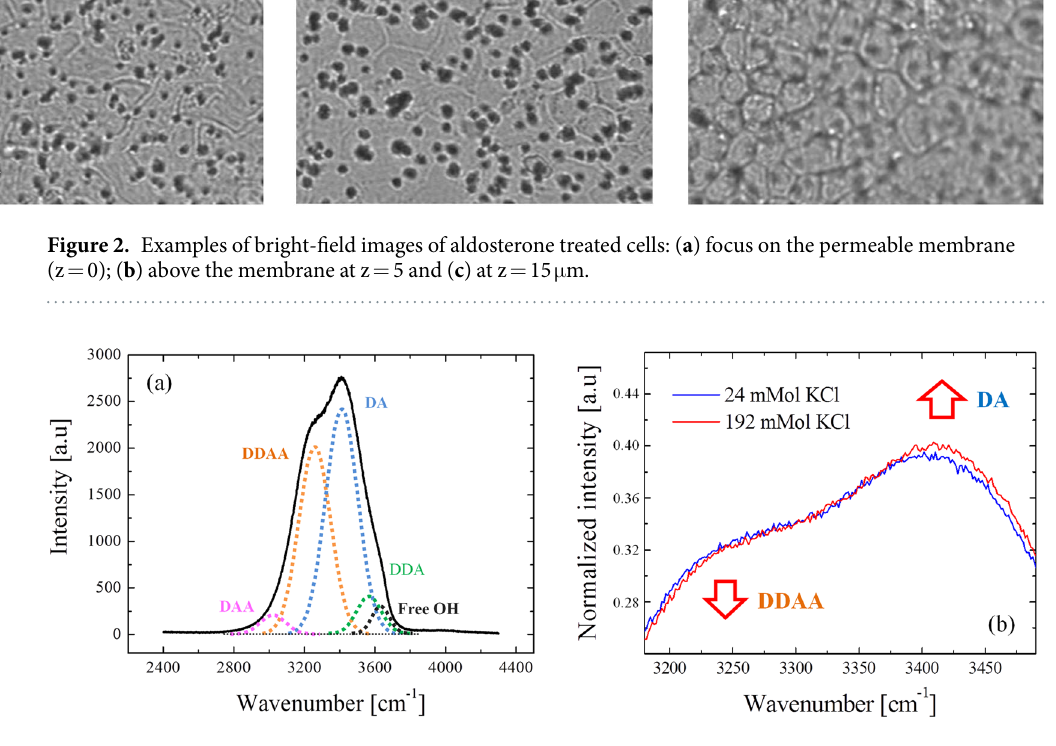
Figure 3. ( a ) Typical Raman spectrum collected from water solutions in the region 2400–4200 cm − 1 and the 5 sub-bands used to interpret the structure of liquid water. ( b ) Example of spectral variation induced by ionic concentration in the millimolar range (total integrated intensity of each spectrum was normalized to